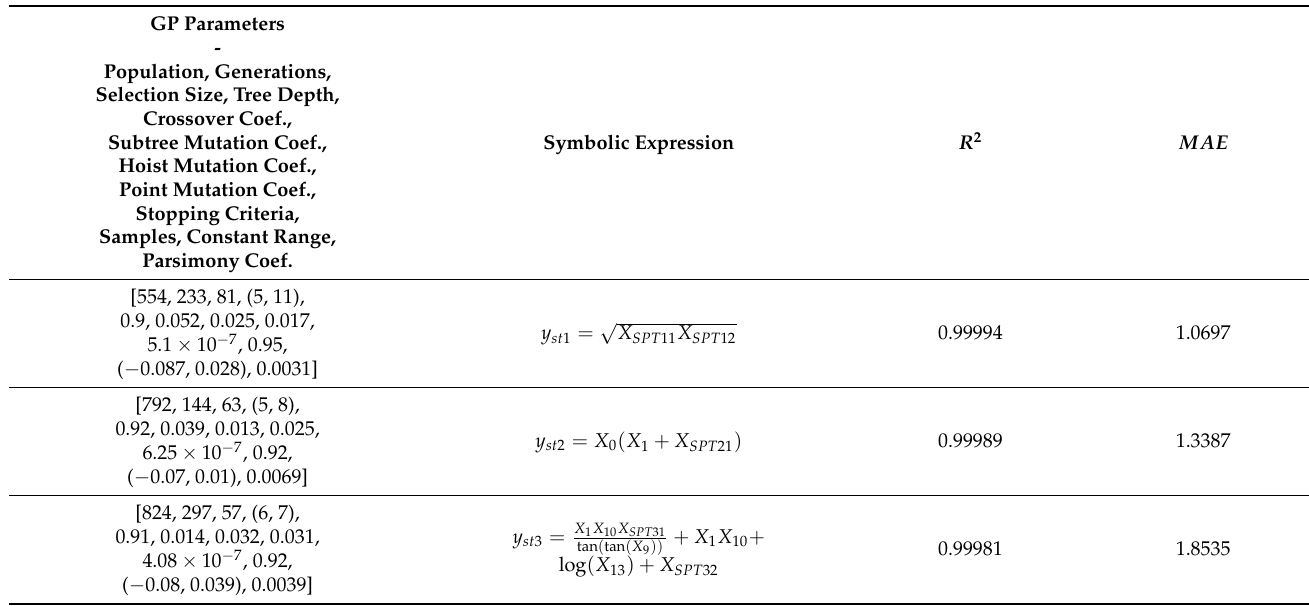
Table 9. Three best symbolic expressions for starboard torque estimation without decay state coefficients with corresponding R 2 and MAE score. GP Parameters